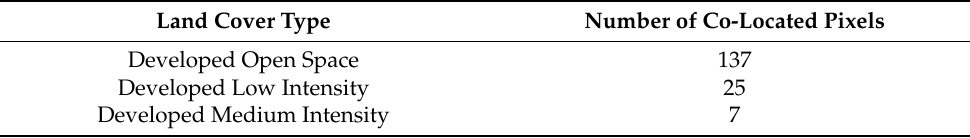
Table 3. Number of 9 km × 9 km grid cells for each of the land cover types in Oklahoma. Land Cover Type Number of Co-Located Pixels Developed Open Space 137 Developed Low Intensity 25 Developed Medium